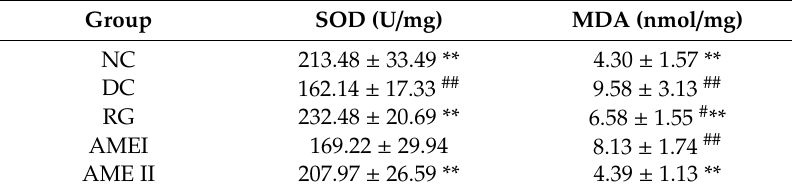
Table 6. E ff ects of AME on malondialdehyde (MDA) level and superoxide dismutase (SOD) activity in _ diabetic mice ( x ± SD, n = 10).